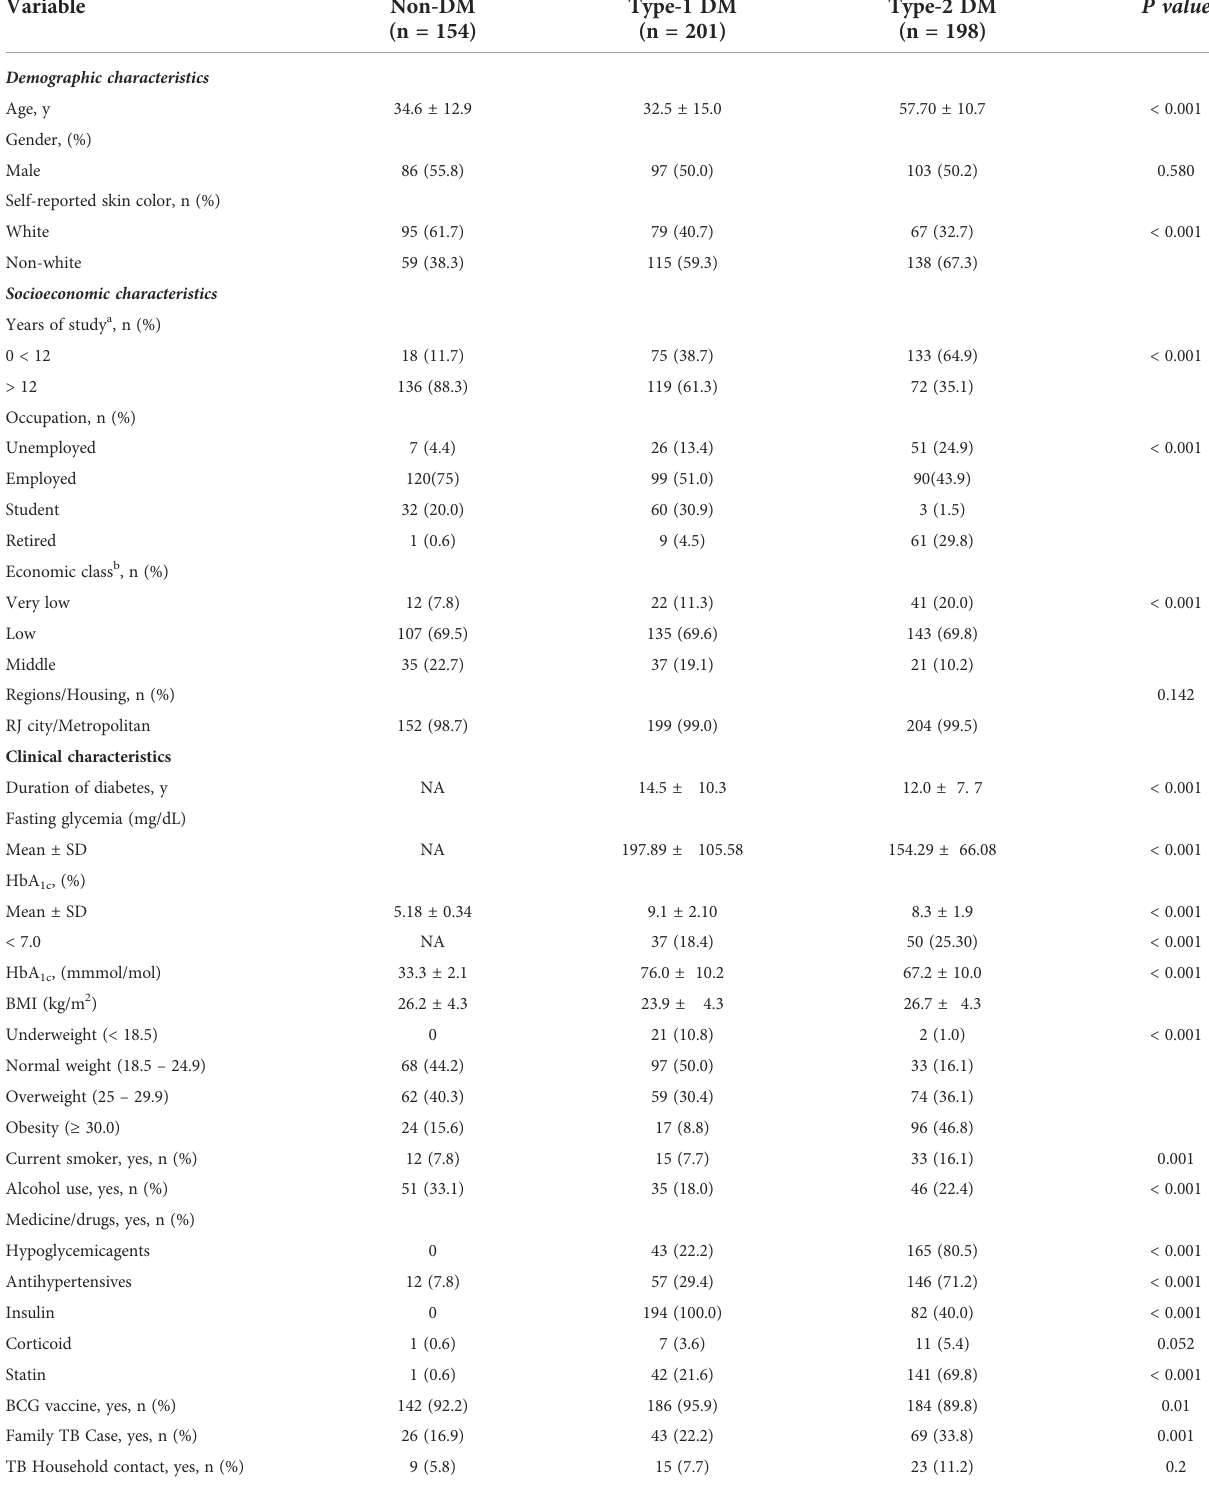
TABLE 1 Baseline characteristics of study